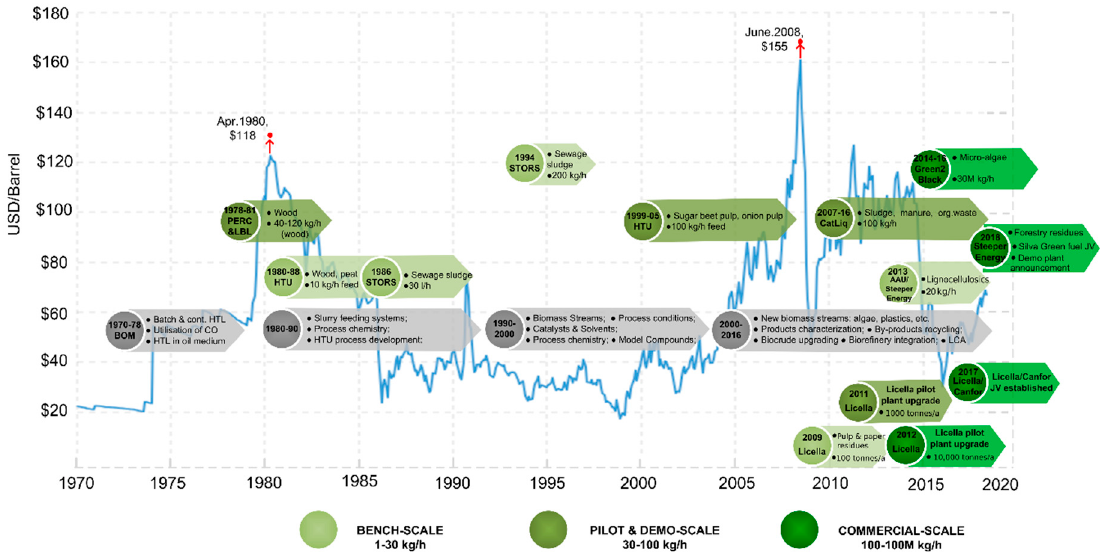
Figure 3. Yearly trend of oil price and main research activities in the field of HTL. Adapted from [79] with permission of the author, © I.M. Sintamarean 2017.